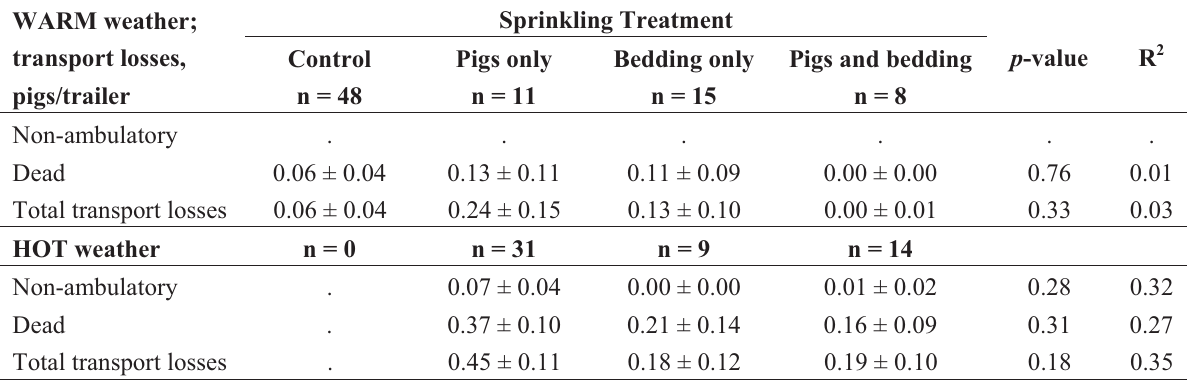
Table 5. Experiment 2. Effects of sprinkling 1 on transport losses 2 in market weight pigs in WARM 3 and HOT 4